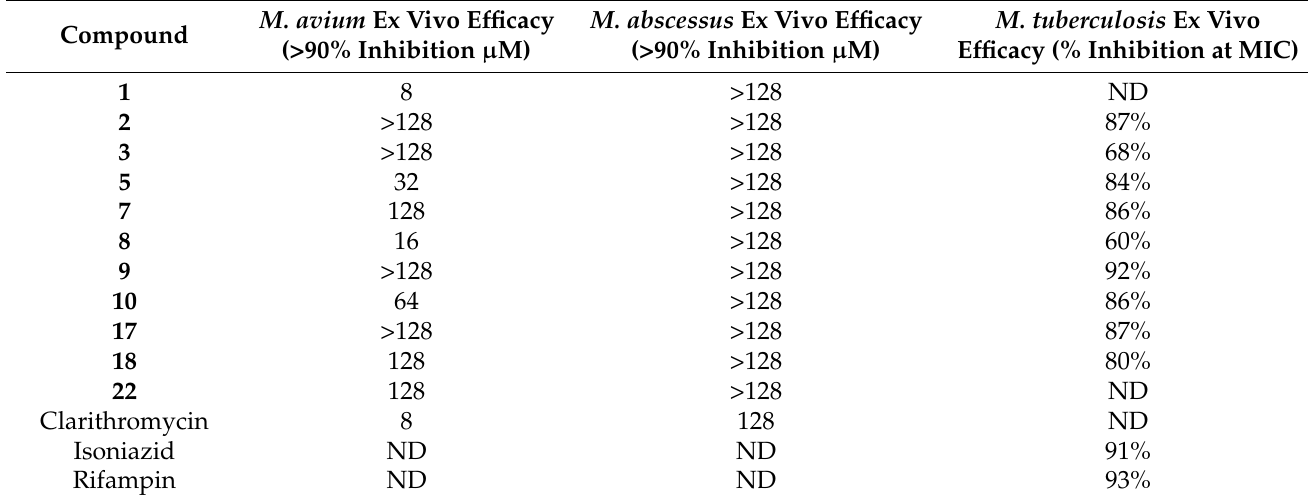
Table 5. Ex vivo results for the tested compounds. The